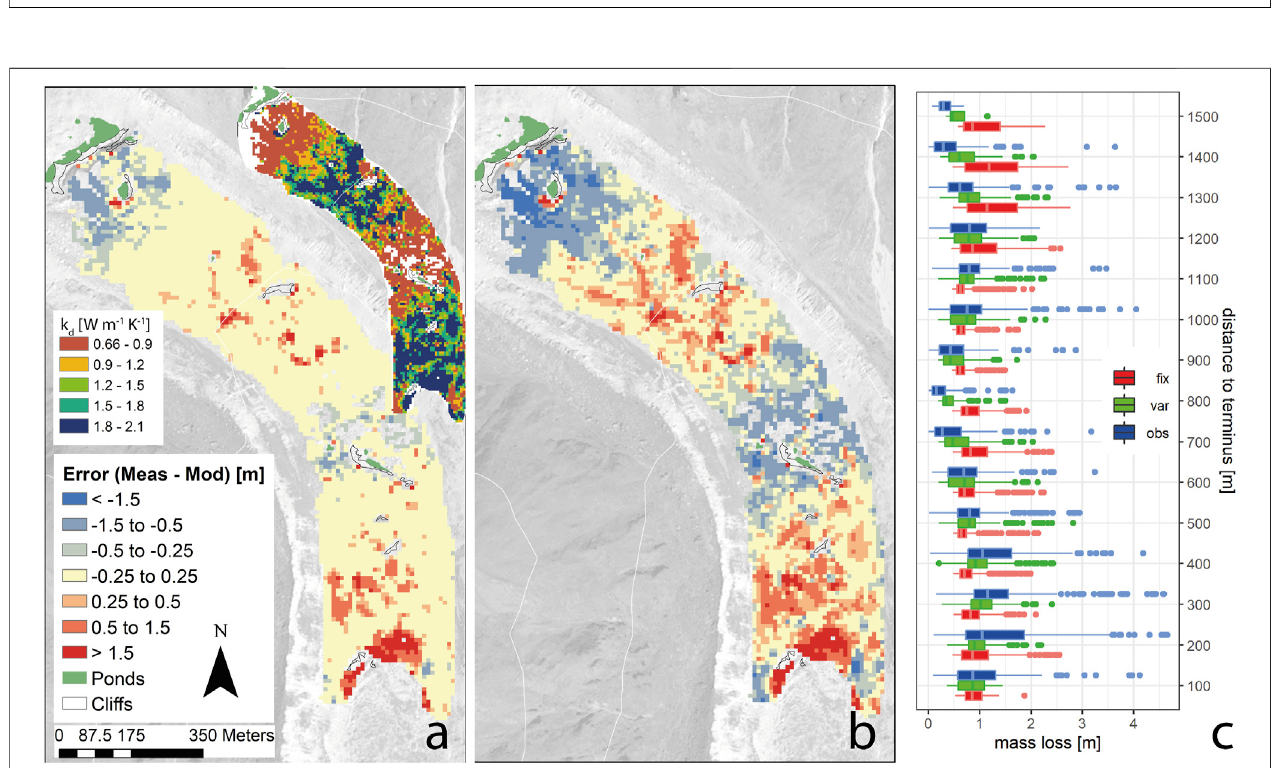
FIGURE 10 | (A) Difference between observed and modeled melt with variable (shown as an inset) and (B) constant conductivity k d . (C) Melt over all pixels for the observed (obs), variable k d (var) and fi xed k d ( fi x) case, binned in distance to the terminus.